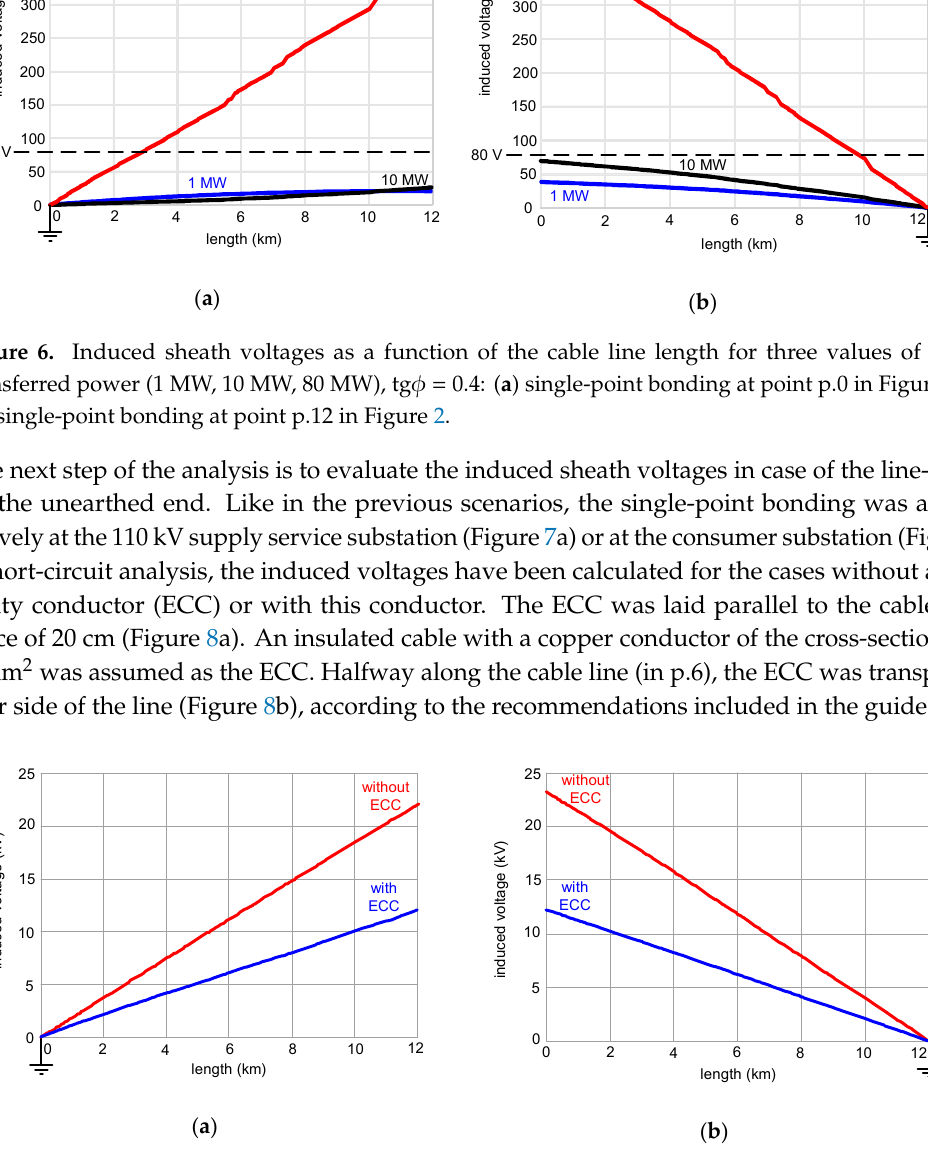
Figure 7. Induced sheath voltages as a function of the cable line length, in case of the line-to-earth fault at the unearthed end; single-point bonding at: ( a ) supply service substation (point p.0 in Figure 2); ( b ) consumer substation (point p.12 in Figure 2).